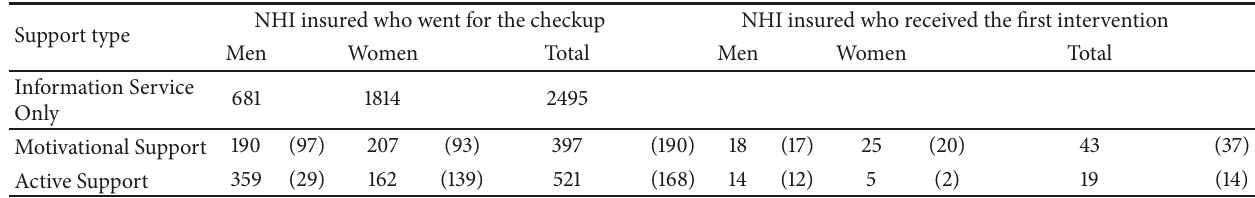
Table 1: Support type after the